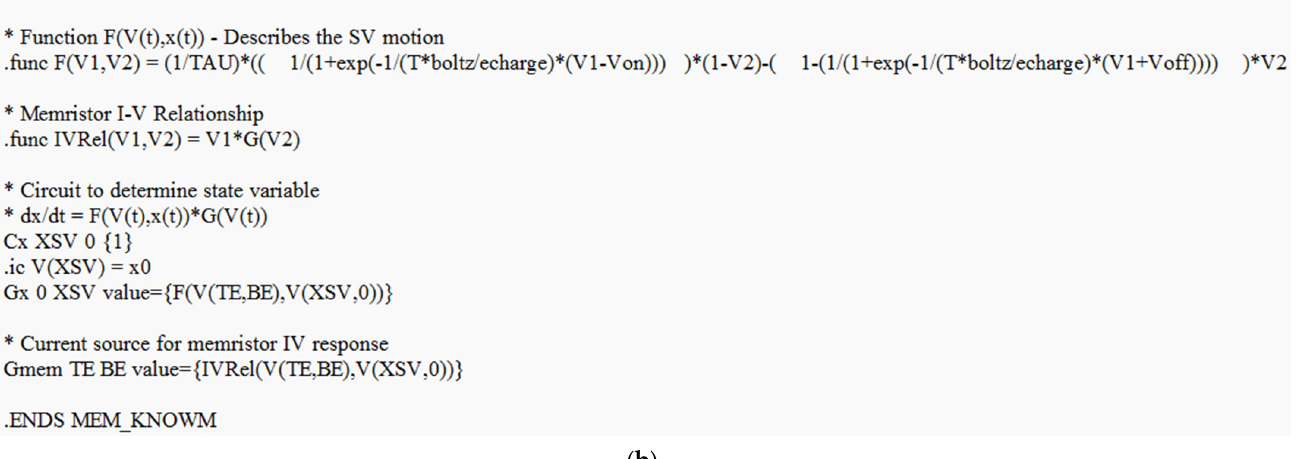
Figure 1. Memristor simulation circuit, MEM_ Knowm is the model of Knowm memristor, and XSV is the state variable. ( a ) Schematic ( b ) Knowm memristor model.